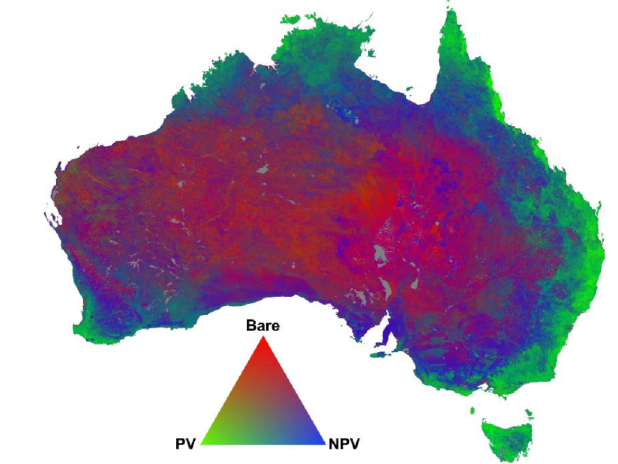
Figure 3. A multilayer FCover composite derived from Landsat 5 and available at the Terrestrial Ecosystem Research Network (TERN) AusCover remote sensing data archive